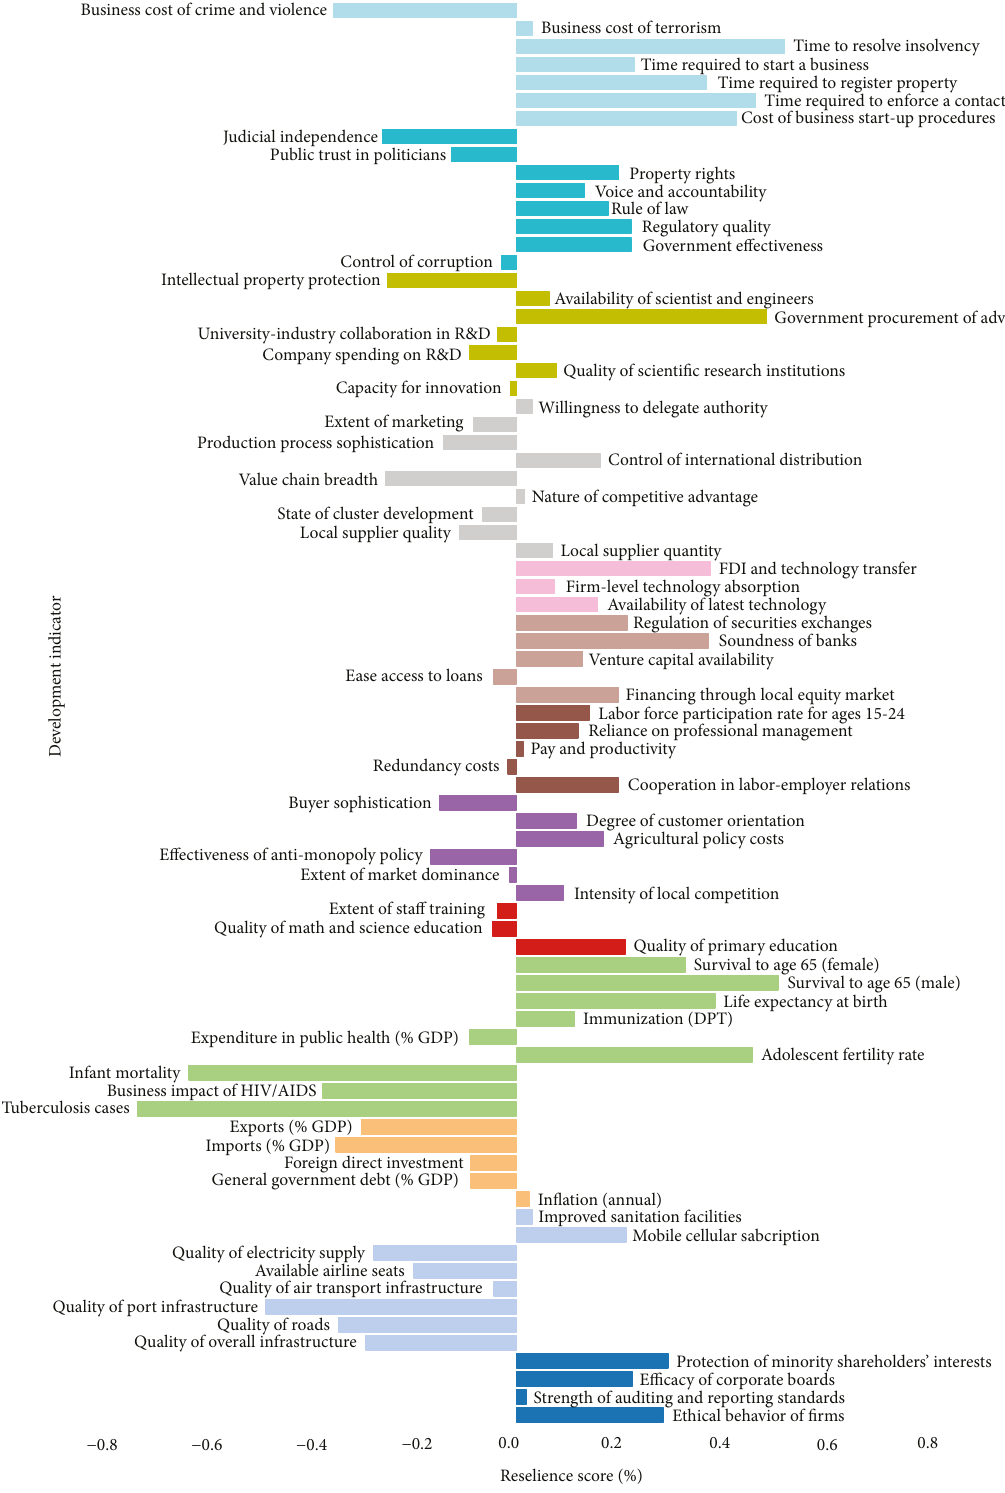
Figure 10: Average resilience by development